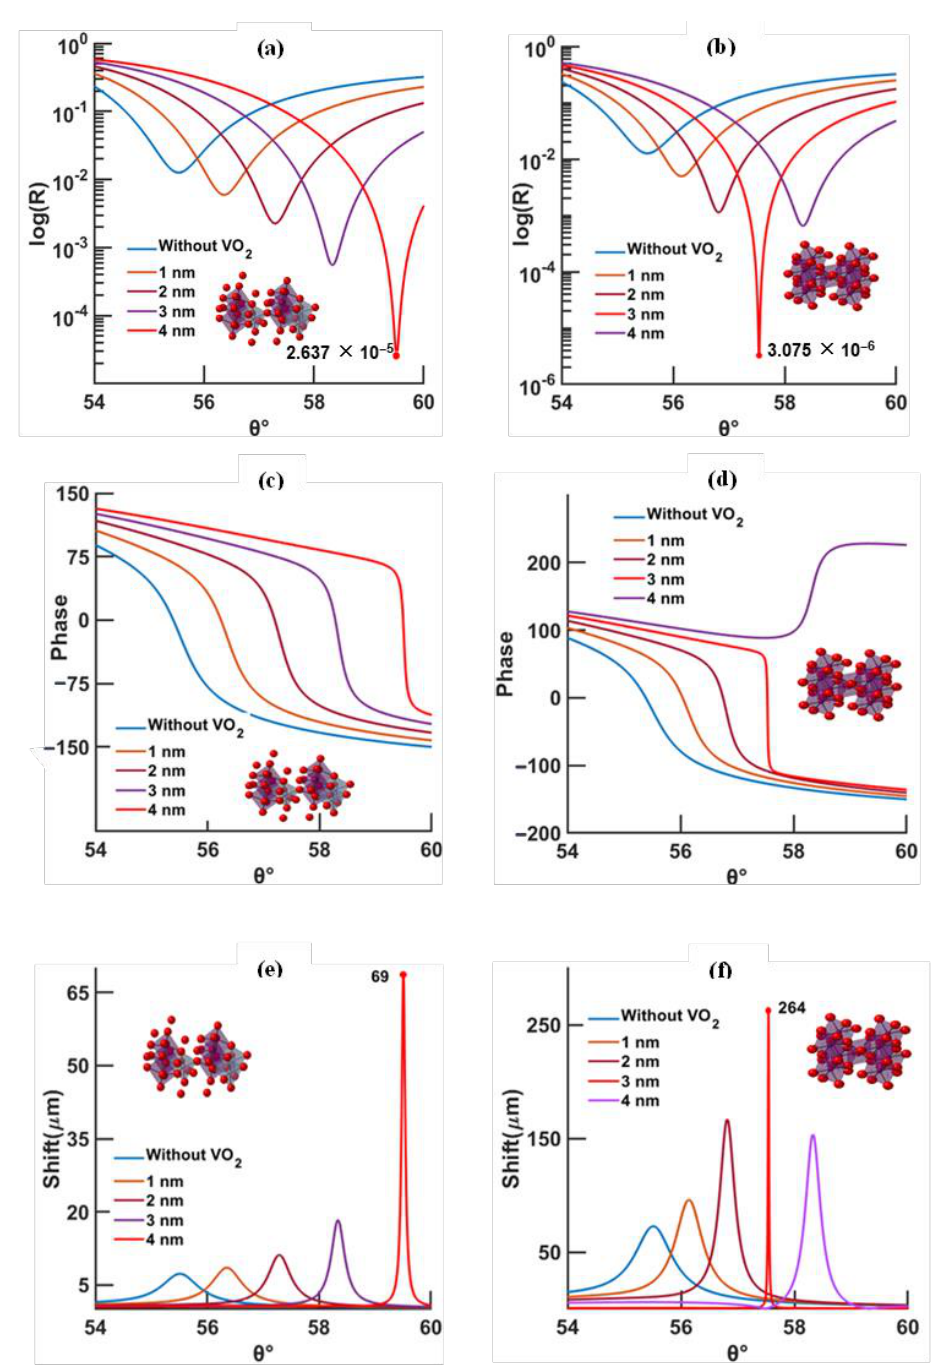
Figure 3. SPR curves with respect to the thickness of VO 2 calculated by TMM model, for an excitation of 630 nm, VO 2 temperature of 20 ◦ C (left) and 95 ◦ C (right), and a gold thickness of 46 nm; ( a , b ) reflectivity, ( c , d ) phase, and ( e , f ) Goos–Hänchen shift (absolute value).